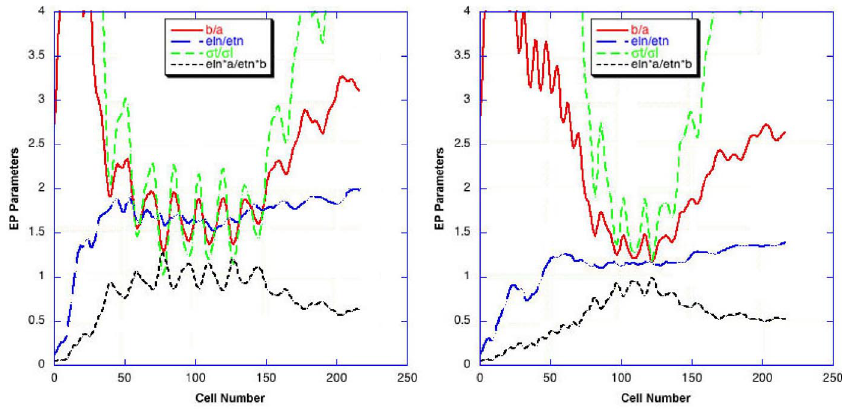
FIG. 3. (Color) EP parameters of the PKU deuteron RFQ (Left: before optimization; right: after